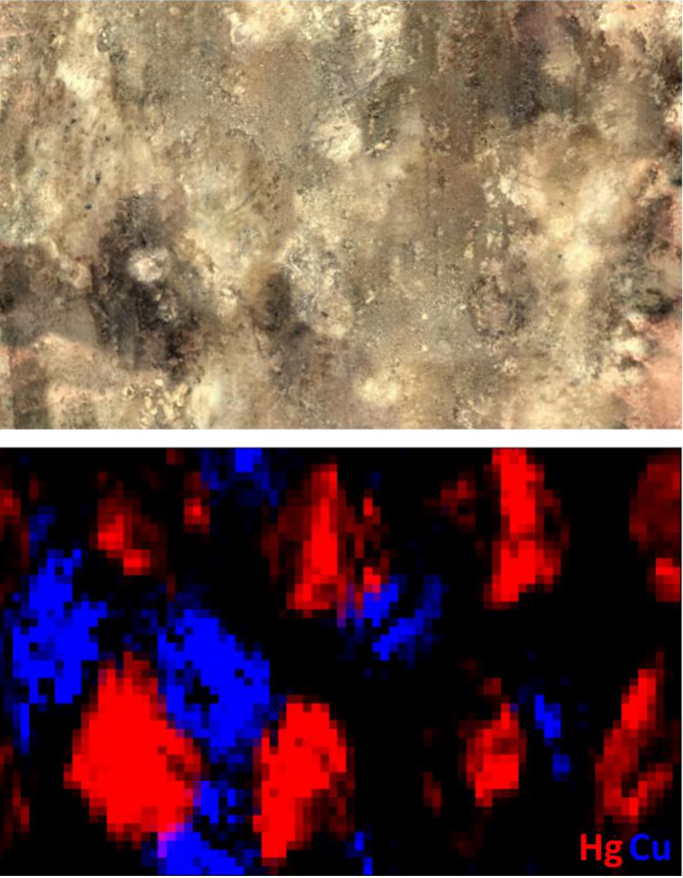
Figure 7. Composite elemental maps of Cu and Hg reconstructing the scale design on the chest of the sphinx (area C of Figure 4). The VIS image at the top shows how altered this area is.